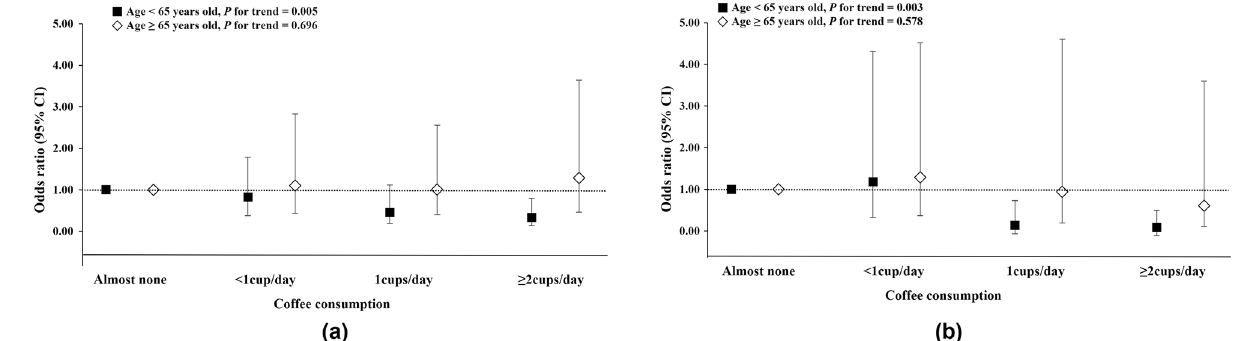
Figure 2. Prevalence of diabetic retinopathy (DR) in terms of coffee consumed among patients with type 2 diabetes by age. Odds ratio of ( a ) any DR and ( b ) vision-threatening diabetic retinopathy (VTDR). The prevalence of any DR and VTDR significantly lowered with higher coffee consumption in all participants ( P for trend = 0.025 and 0.005, respectively). When the population was divided into two groups according to age, the trend was significant in participants aged < 65 years ( P for trend = 0.005 and 0.003, respectively) but not in those aged ≥ 65